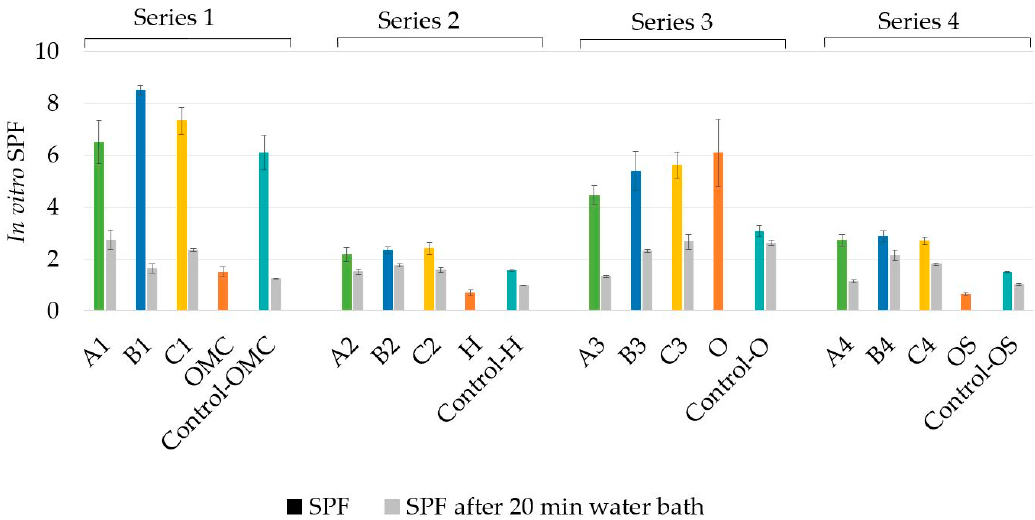
Figure 2. In vitro sun protection factor (SPF) of Series 1–4 sunscreens compared to the individual ultraviolet (UV) filters and control formulas. OMC: OM cinnamate; H: homosalate; O: octocrylene; OS: octyl salicylate; Si: silicone resin; A: alkenones; B: beeswax; C: cetyl alcohol.